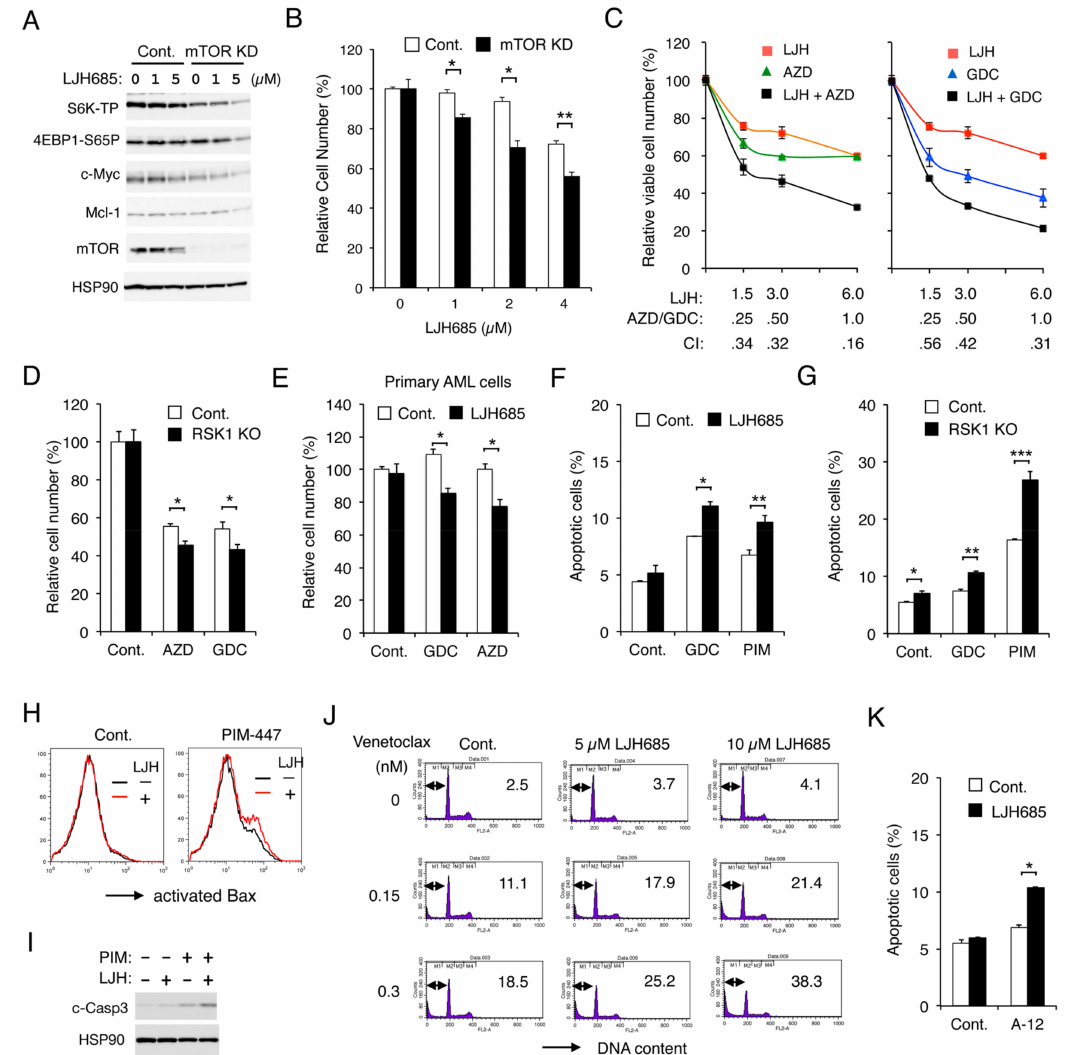
Figure 6. Inhibition of RSK and that of PIM or PI3K cooperatively inhibit proliferation and cooperatively induce apoptosis through the mitochondrial apoptotic pathway in FLT3-ITD-positive AML cells. ( A ) MV4-11 cells knocked down of mTOR (mTOR KD) or vector control cells (Cont.), as indicated, were treated for 6 h with indicated concentrations of LJH685 and subjected to immunoblot analysis. ( B ) Indicated cells were cultured for 48 h with indicated concentrations of LJH685, and viable cell numbers were measured by the colorimetric assay. Each column represents the mean of triplicate cultures, with error bars indicating standard errors, and is expressed as a ratio to the control cell numbers. The asterisks indicate statistically significant di ff erences from control cells determined by Student’s t -test (* p < 0.005, ** p < 0.01). ( C ) MV4-11 cells were cultured for 48 h with indicated concentrations ( µ M) of LJH685 (LJH), AZD1208 (AZD), and GDC-941 (GDC), and viable cell numbers were measured in triplicate. Combination index (CI) values are indicated. ( D ) MV4-11 cells knocked out of RSK1(RSK1 KO) or vector control cells (Cont.) were cultured in quadruplicate for 48 h with or without 0.3 µ M AZD1208 or GDC-0941, as indicated, and viable cell numbers were measured. * p < 0.05. ( E ) Primary AML cells expressing FLT3-ITD were cultured in the absence (Cont.) or presence of 2.5 µ M LJH685 with 0.2 µ M GDC-0941 or AZD1208, as indicated, for 24 h in quadruplicate, and viable cell numbers were counted after trypan blue staining. * p < 0.005. NS: Not significant. ( F ) MV4-11 cells were left untreated as control (Cont.) or treated with 2.5 µ M LJH685, 0.5 µ M GDC-0941, or 1 µ M PIM-447 (PIM), as indicated, for 16 h, and analyzed. The means of percentages of apoptotic cells with